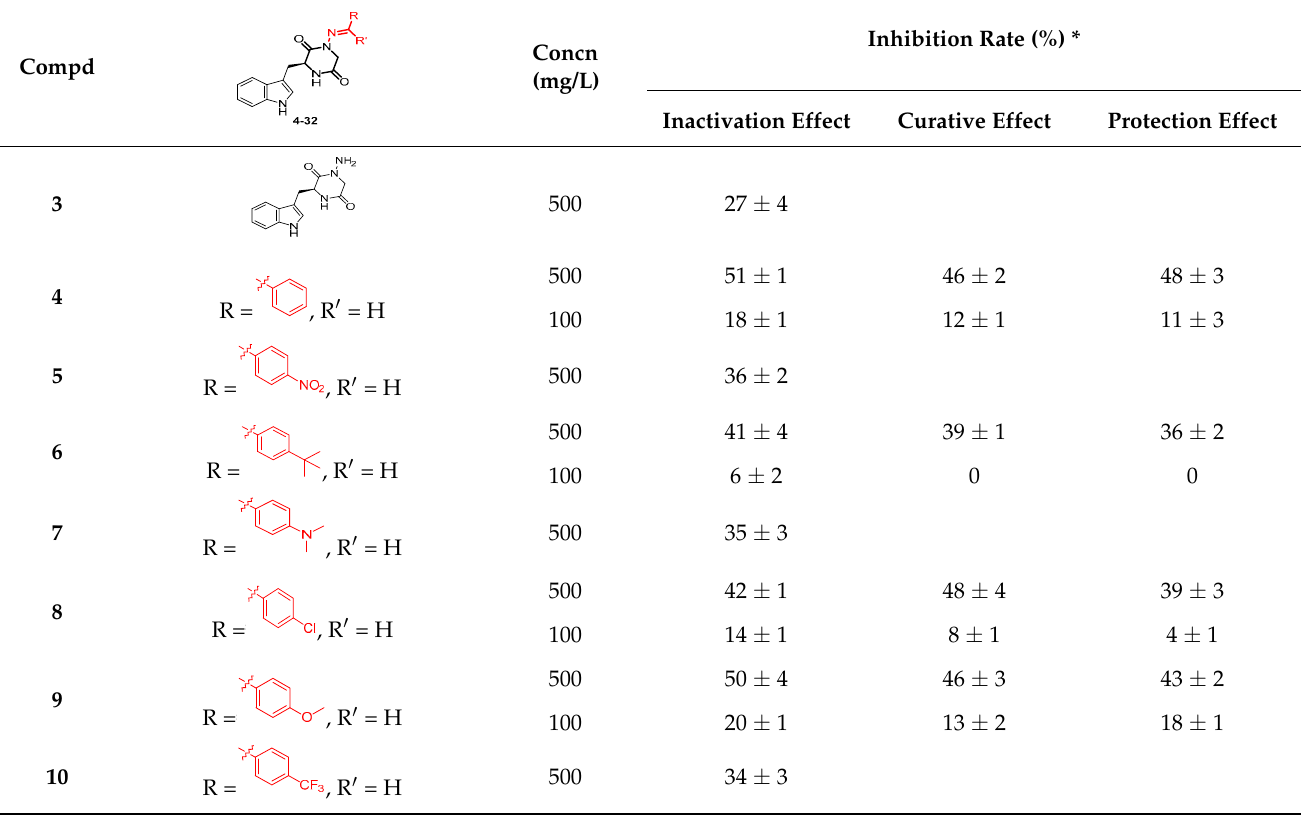
Table 2. In vivo anti-TMV activities of compounds 3 – 32 .